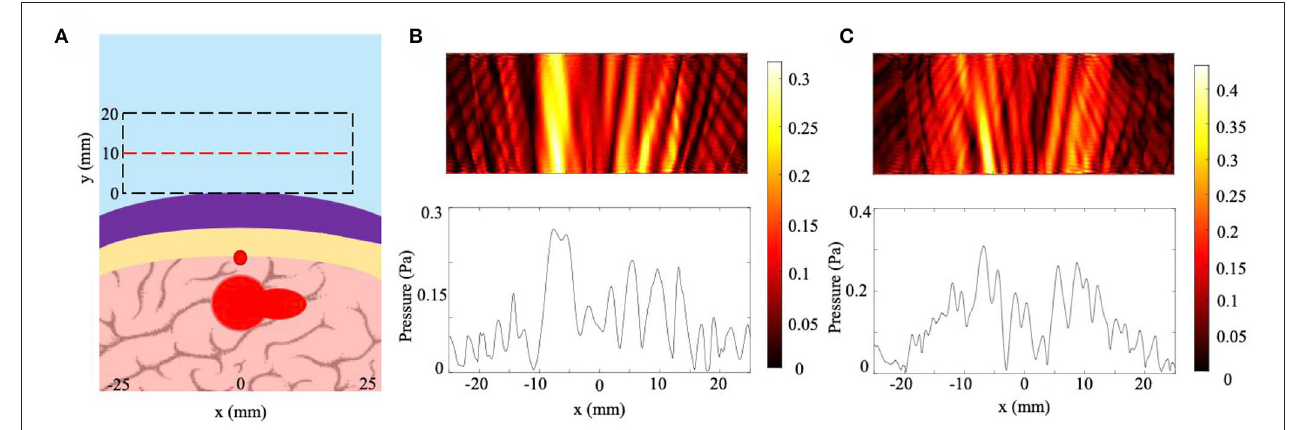
FIGURE 8 | Effects of multiple skull inhomogeneities on ultrasound imaging with NHCMM. (A) Diagram of the skull, NHCMM, blood vessel, and tumor arrangement. The skull was modeled to be curved and increased in thickness toward the right end of the imaging window. The tumor in the diagram is the shape of the pear-shaped irregular tumor. A large blood vessel is located above the tumor which creates a hemispherical indent in the skull. (B) The scattered pressure field of the inhomogeneous skull with a uniform tumor and precisely tuned NHCMM. (C) The scattered pressure field of the inhomogeneous skull and irregular tumor with a precisely tuned NHCMM to match the skull geometry. The colorbars represent pressure amplitudes in